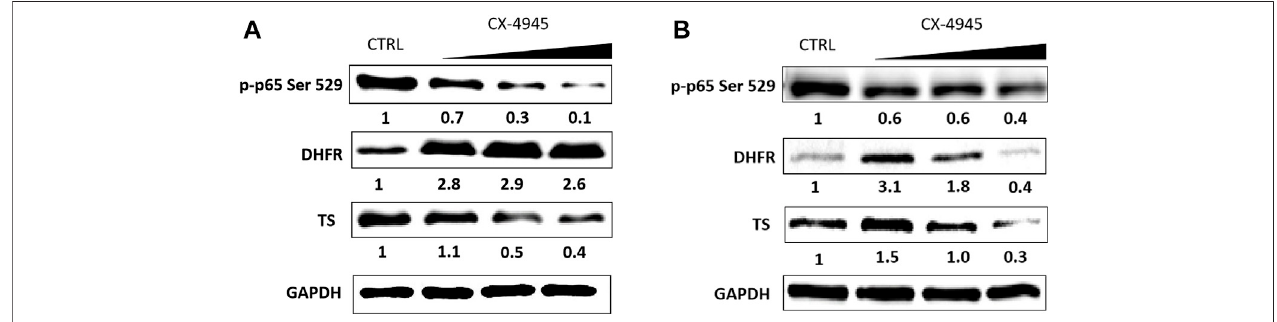
FIGURE 1 | The effect of CX-4945 on the level of p-p65 Ser 529 (nuclear factor kappa-light-chain-enhancer of activated B cells), DHFR, and TS in CCRF-CEM (A) and in A-549 (B) . Westernblot analysisof the following proteinsin the crude extracts obtained from the tested cell lines after 48 h of treatment with CX-4945used in the concentrations of15.54,31.08,and 46.62 µM forA-549 and 2, 4,and 8 µM for CCRF-CEM. GAPDH wasused asaloadingcontrolfor each sample. Preparation ofcell extracts and protein detection are described in Materials and Methods . Densitometry quanti fi cations for each tested protein, given under each cell line panel, were calculated with untreated cells (CTRL) serving as the reference